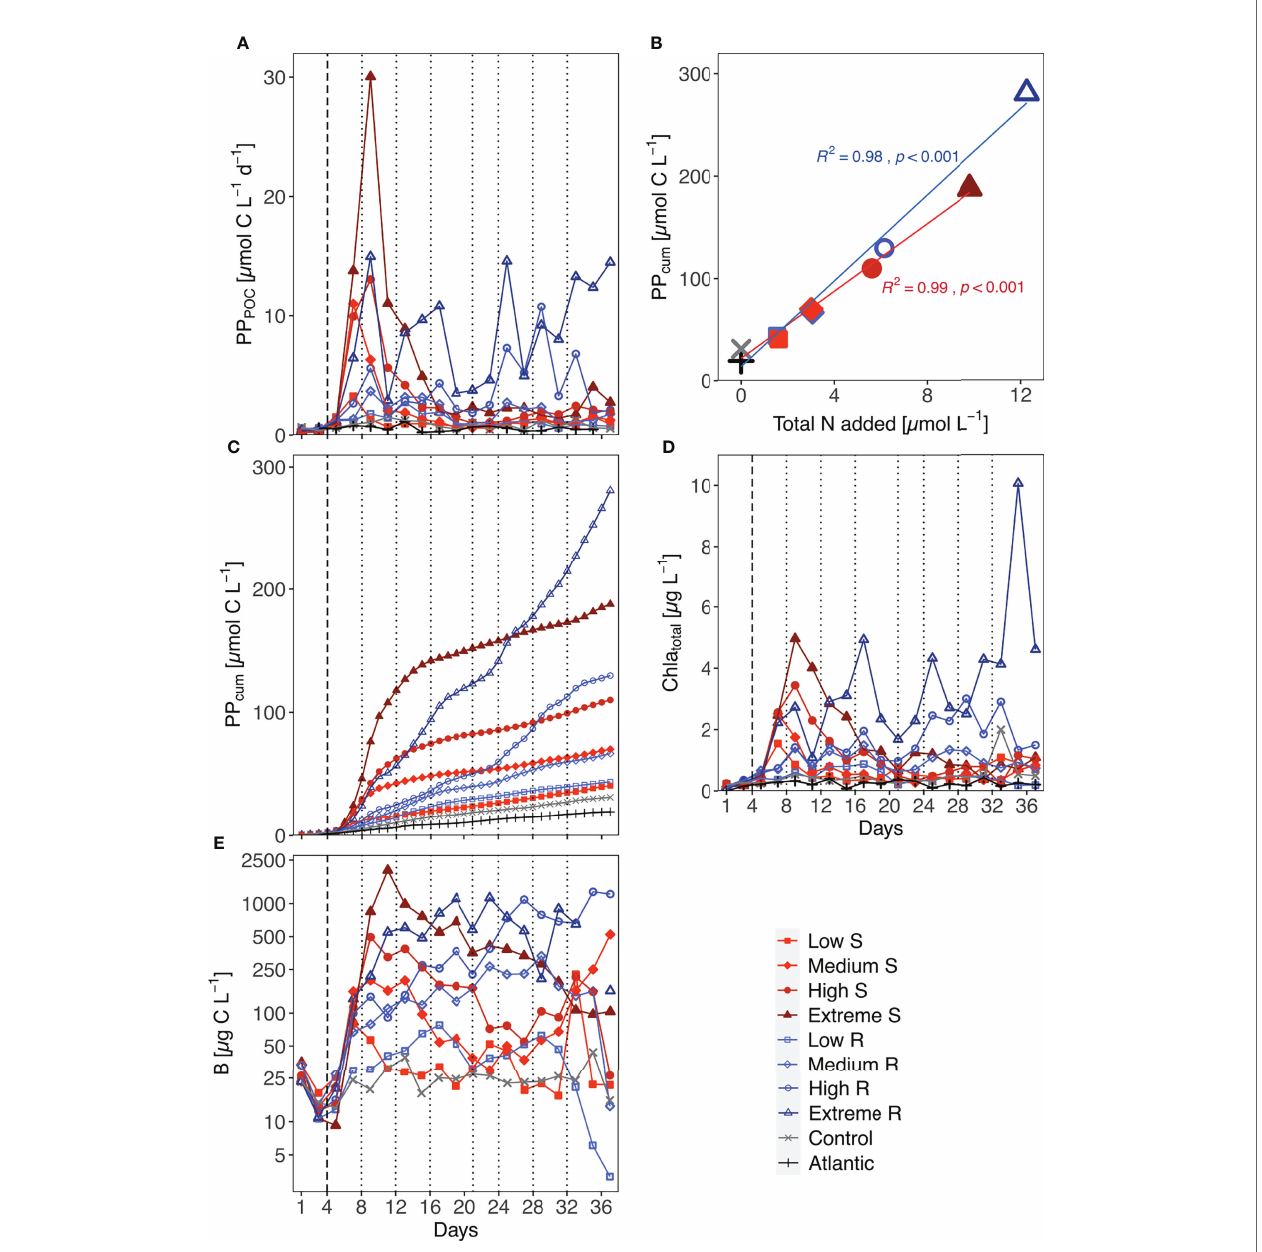
FIGURE 1 | Temporal development of (A) total primary production (PP POC ), (C) accumulated primary production (PP cum , even day data points calculated as described in 2.3), (D) total Chla concentration and (E) total phytoplankton biomass (mind the logarithmic y-axis scale). Biomass values of the Atlantic were not measured. S, Singular; R, Recurring. (B) shows the accumulated organic carbon production per µmol of nutrients added at the end of the experiment. Linear regression shown for singular (n = 5) and recurring (n = 5) treatments; Difference between both upwelling modes as a whole was signi fi cant (p=0.029). Dotted lines represent DW additions, dashed line marks the single DW addition to singular